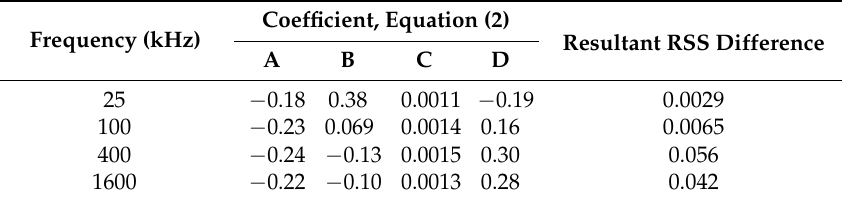
Table 3. Equation (2) coefficient values. Residual sum square (RSS).